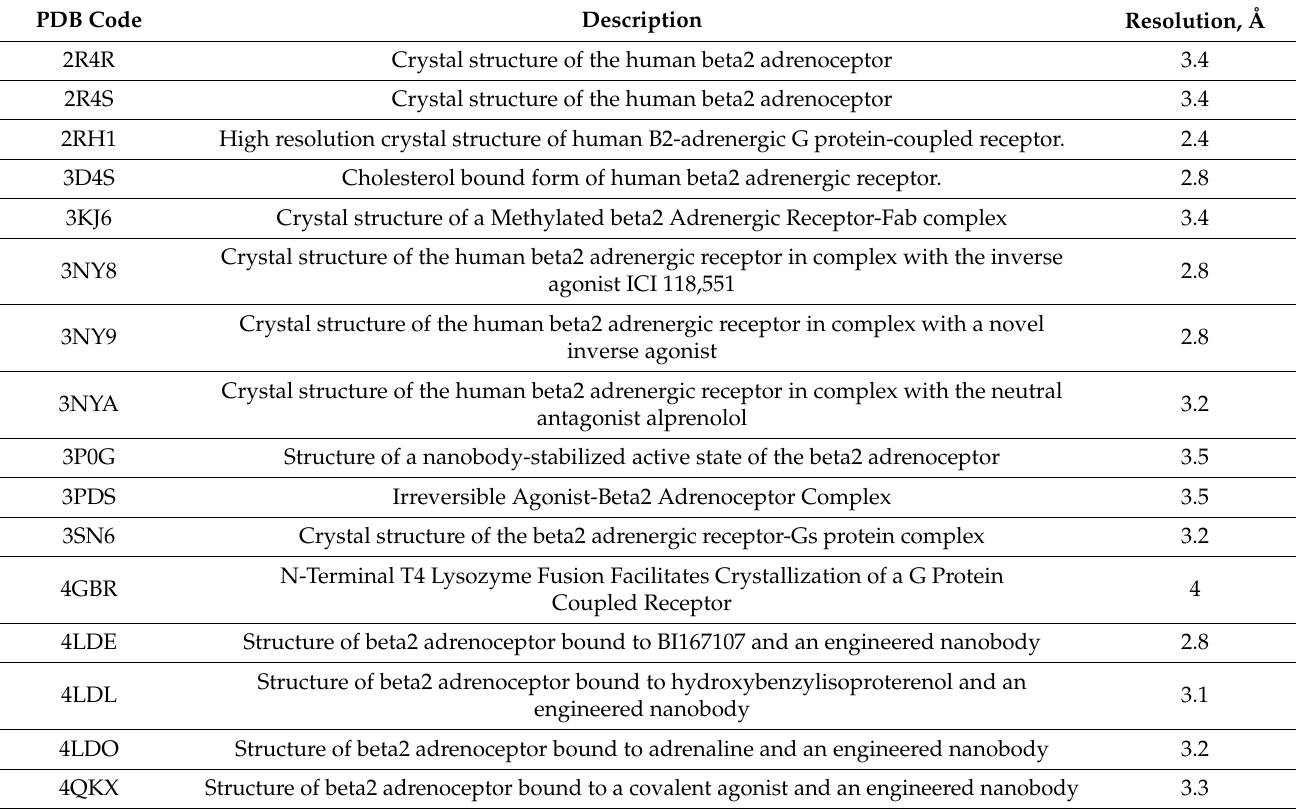
Table A1. A list of all β 2-adrenergic receptor ( β 2AR) structures used in Figures 2, 3 and 6. Included are the PDB code, description, and resolution in Ångströms. Structure 5JQH was not included in analyses due to heavily skewing the data as it is nanobody